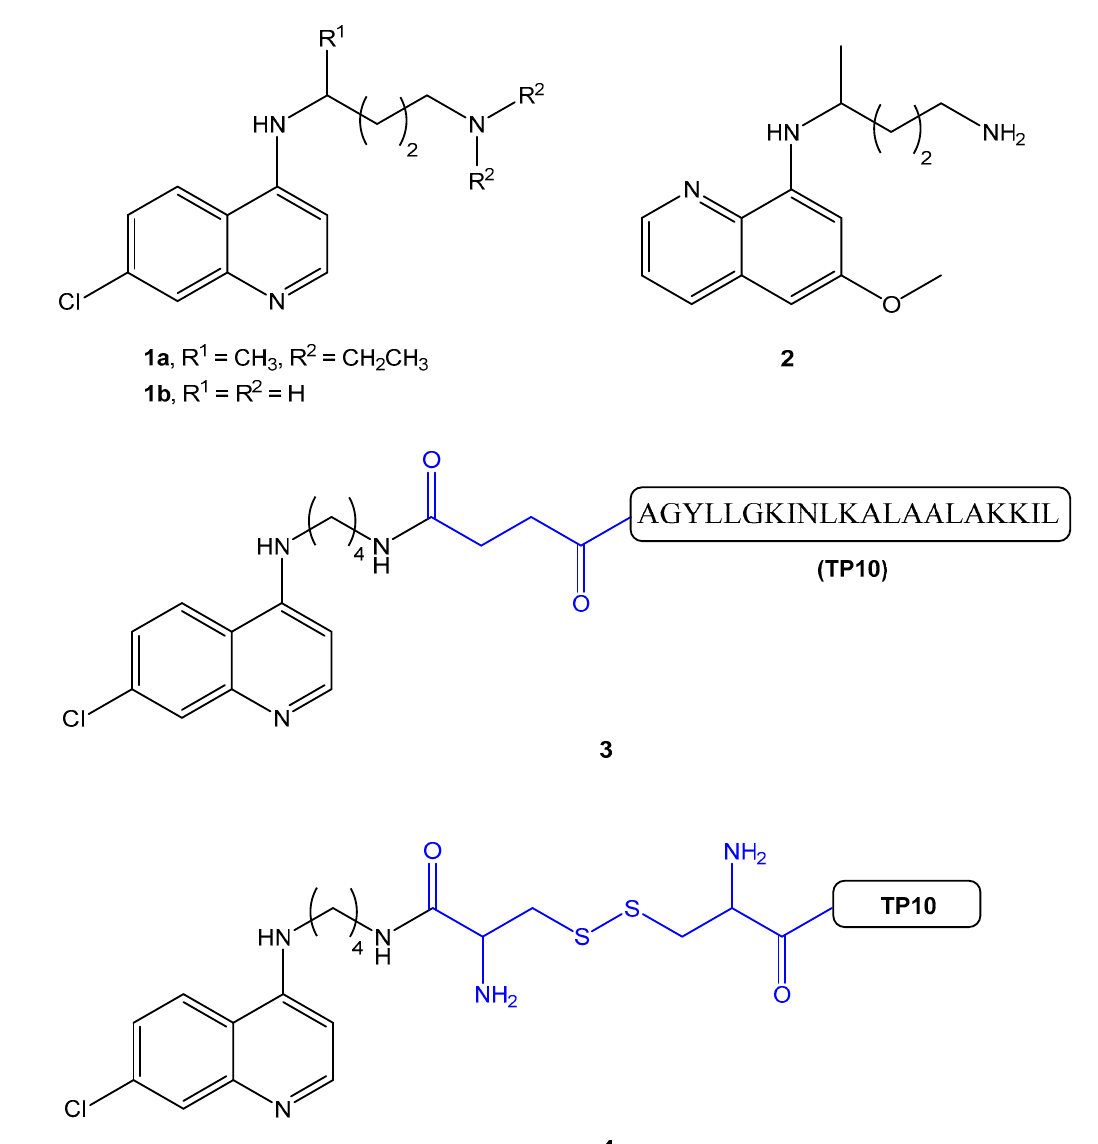
Figure 1. Structures of the antimalarial drugs blood-schizonticide chloroquine (CQ) (1) and gametocytocide primaquine (PQ) (2), and of the CQ-TP10 conjugates CQ-C4-TP10 (3) and CQ-S-S-TP10 (4). The full amino acid sequence (in single letter code) of TP10 is shown for conjugate 3 [24].